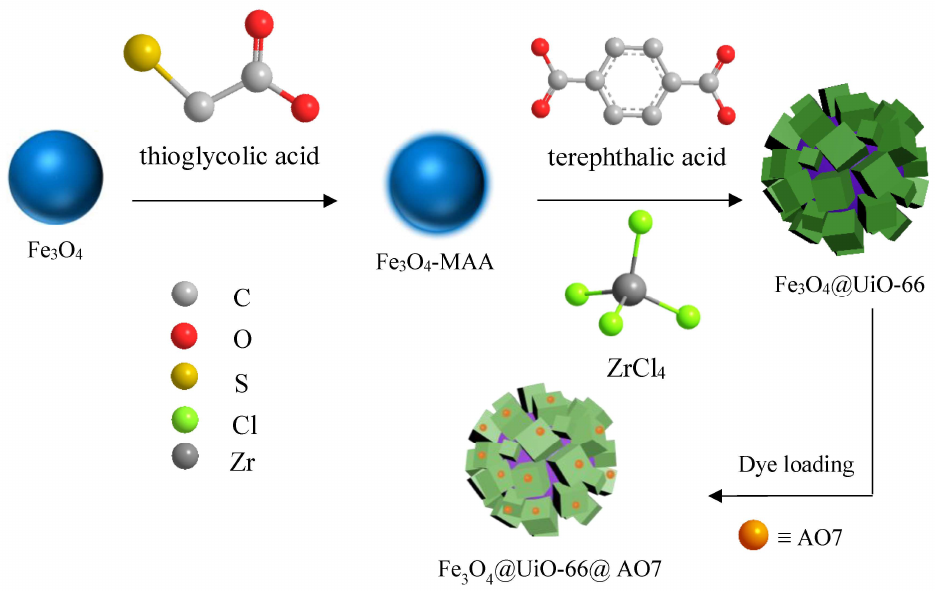
Figure 1. The concept of synthesis of Fe 3 O 4 @UiO-66.